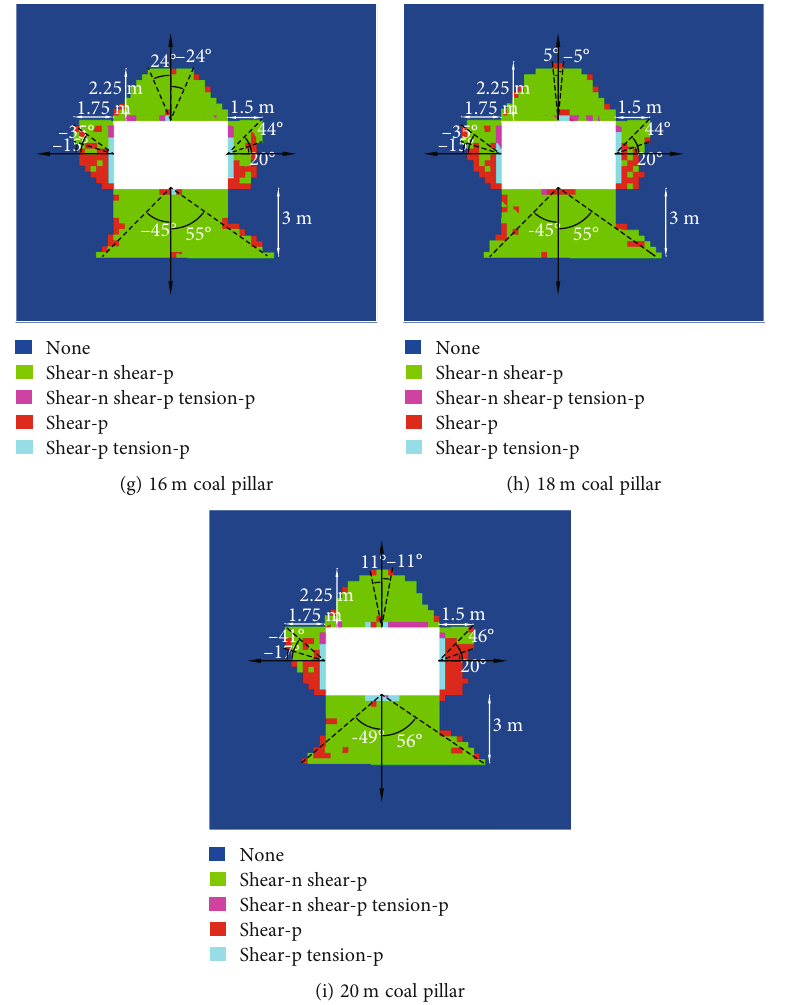
Figure 6: The form distribution of plastic zone of roadway surrounding rock. (left side is coal pillar, right side is coal